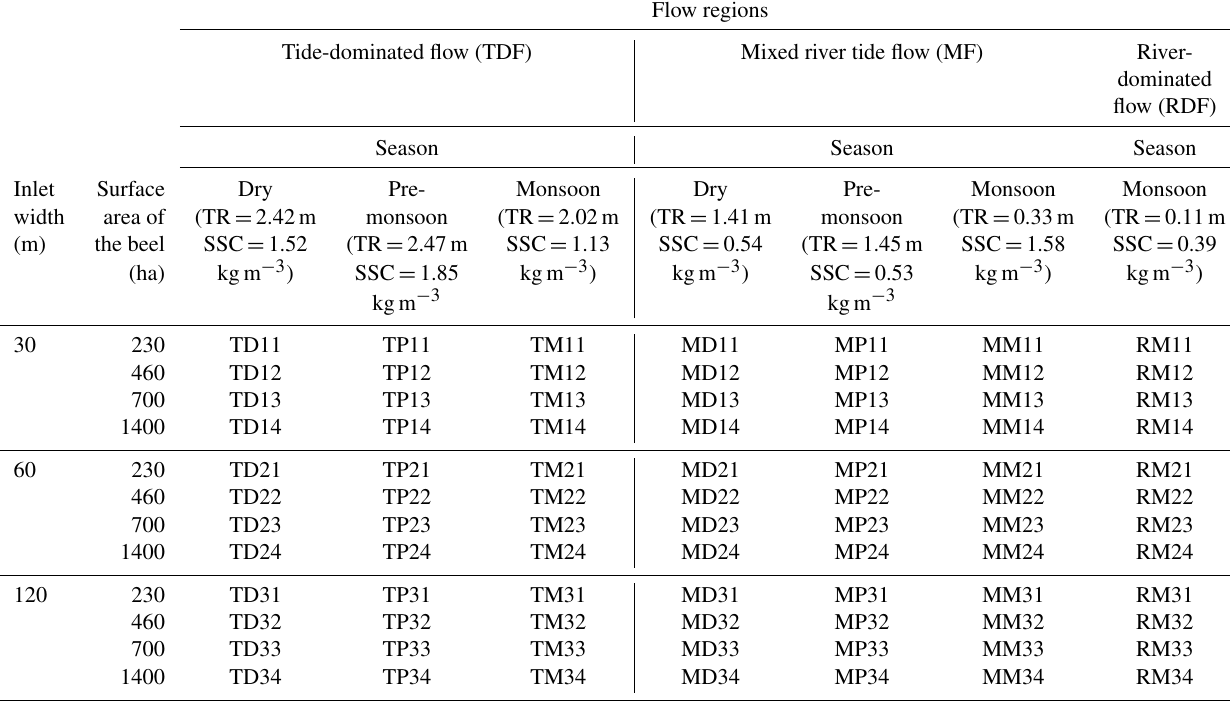
Table 2. Scenario matrix, combining beel surface area and inlet width with different flow regimes and seasons. TR is the tidal range, and SSC is the suspended sediment concentration in the feeding